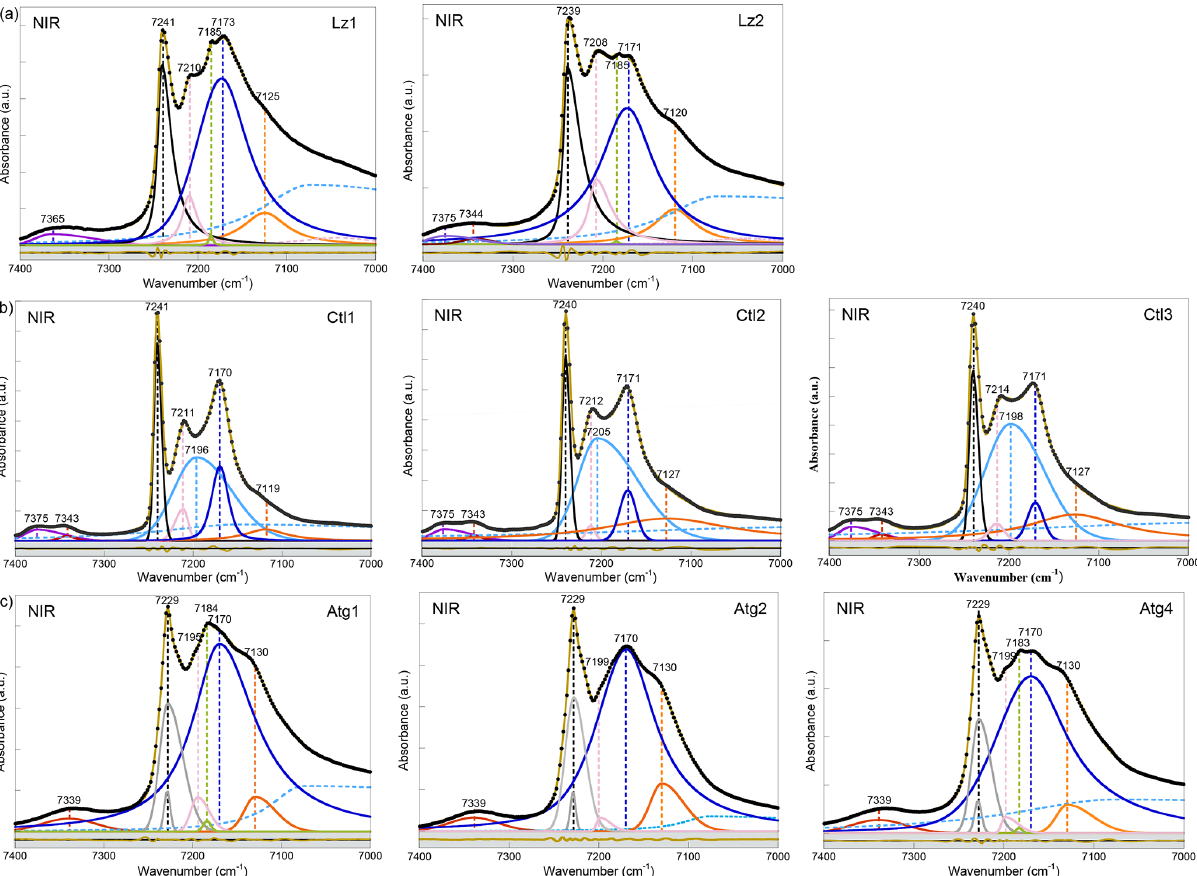
Figure 3. NIR spectra in the 7400–7000cm − 1 range (first overtone region of OH stretching bands) of (a) lizardite (Lz1, Lz2), (b) chrysotile (Ctl1, Ctl2, Ctl3), and (c) antigorite (Atg1, Atg2, Atg4). The spectra have been decomposed into individual components using asymmetric Lorentzian–Gaussian functions. Black dots: experimental data. Solid brown line: best fit (residues in bottom grey box). Plain black, grey and pink curves: inner OH stretching modes. Plain blue and orange curves: interlayer OH stretching modes. Dashed light blue curve: H 2 O vibration